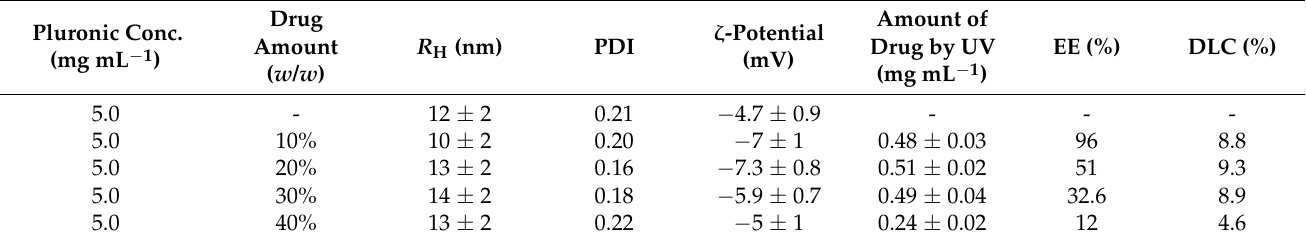
Table 3. Results for DLS, ELS, and drug content evaluation for PEO 113 -PCL 118 micelles with the best CIP concentrations. PEO/PCL Conc.